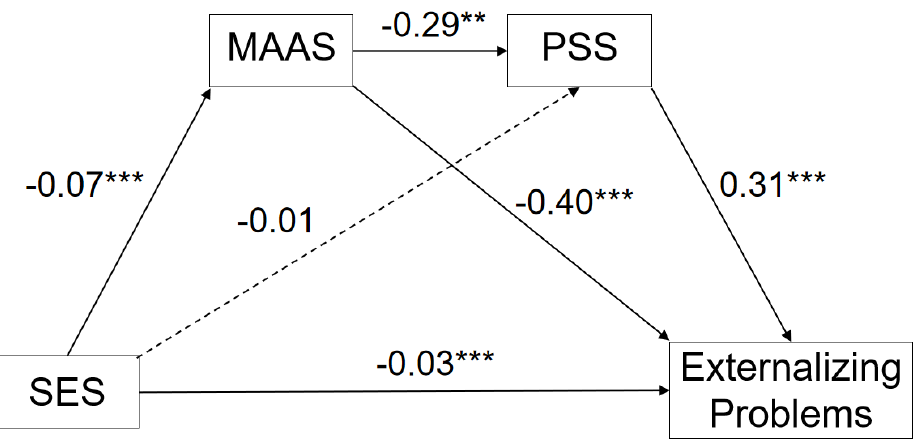
Figure 3. Serial Mediation Model of Socioeconomic to Externalizing Problems. ** p < 0.01. *** p < 0.001. Table 4. Analysis of mediation effect.